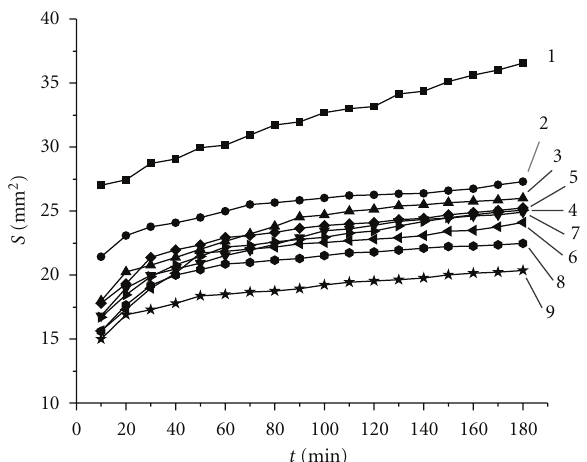
Figure 1: Kinetic wear curves of UHMWPE-based specimens: (1) pure UHMWPE; nanocomposites: UHMWPE +0.1 (2), +0.5 (3), +1 (4), +2 (5) wt.% HA and microcomposites UHMWPE: +5 (6), +10 (7), +20 (8), +40 (9) wt.% HA.